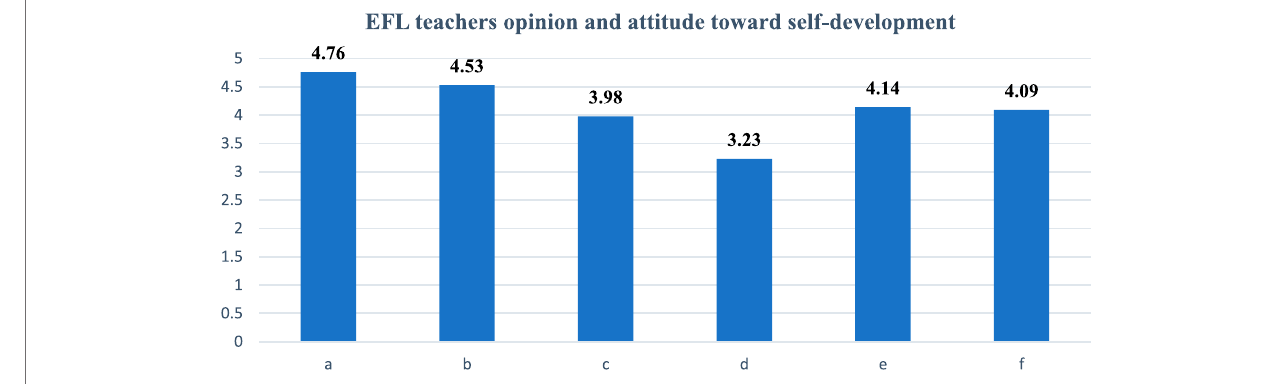
FIGURE 1 | EFL teachers ’ opinion and attitude towards self-development as a reason for professional growth.